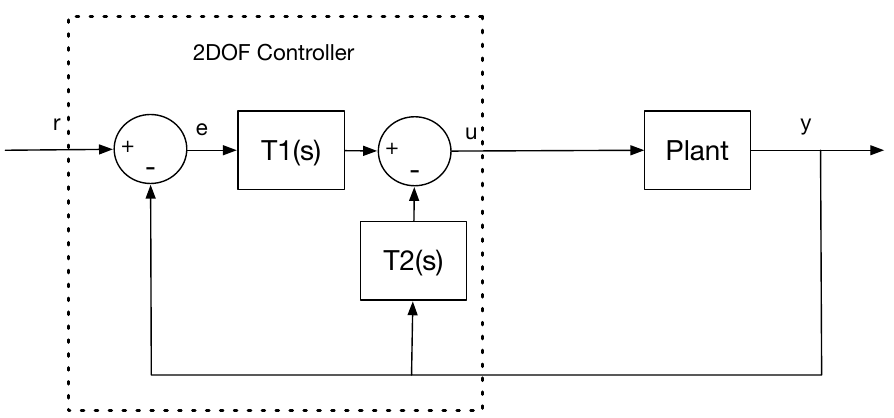
Figure 10. Feedback configuration of an equivalent decoupled 2DOF